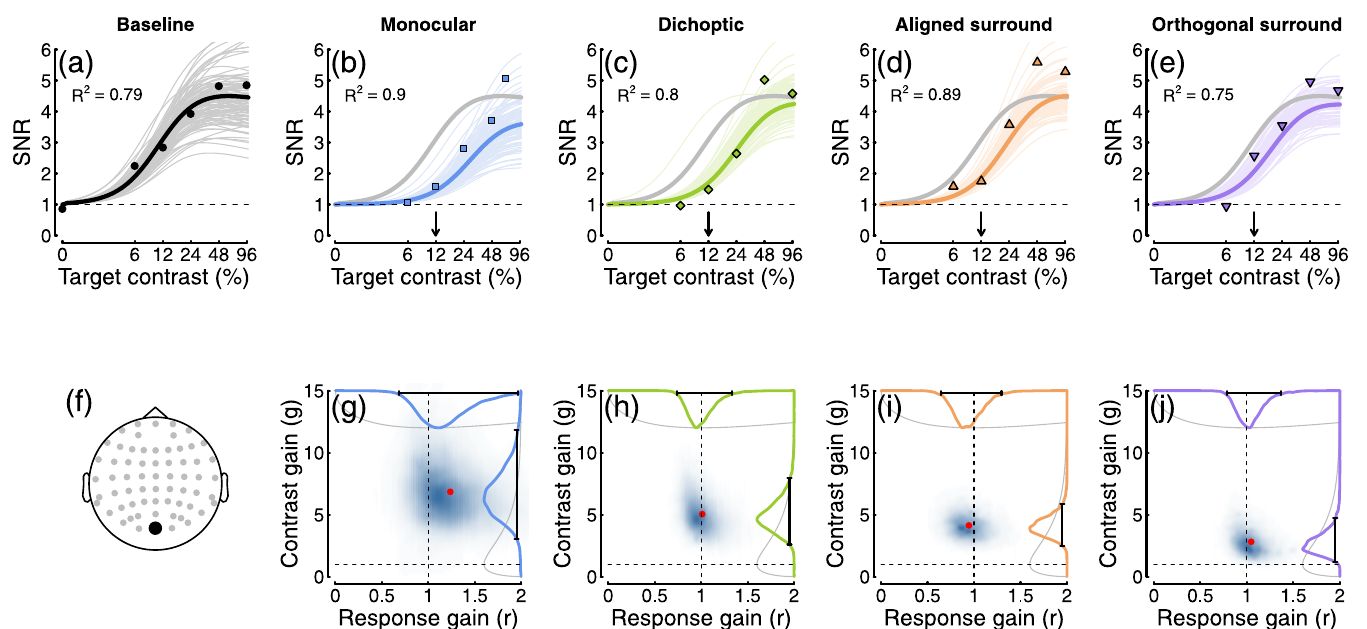
Fig 4. Contrast response functions from electrode Oz , with example model fits and posterior parameter estimates. Panel A shows the data from the baseline (no mask) condition (points), plotted alongside model curves for the mean posterior parameter estimates (thick curve), and random posterior samples (thin curves). Panels B-E show data for four types of mask in the same format (grey curves duplicate the mean fit from panel A), with the arrows indicating the mask contrast. The R 2 values are derived from the fits to the individual participant data, rather than the group averaged data plotted here. Panel F shows the electrode location. Panels G-J show posterior density estimates for the response gain (x-axis) and contrast gain (y-axis) weight parameters. Red points show the means, dashed lines give the value expected in the case of no effect (a weight of 1), and distributions along the margins show the prior (grey) and posterior (coloured) distributions for each parameter. For all mask types, the contrast gain weight estimate was substantially greater than